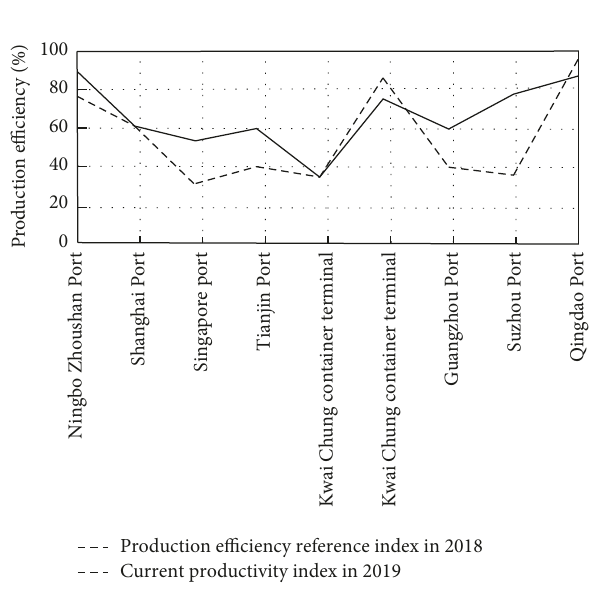
Figure 3: Distribution chart of “Reference Index” and “Current Index” of nine major